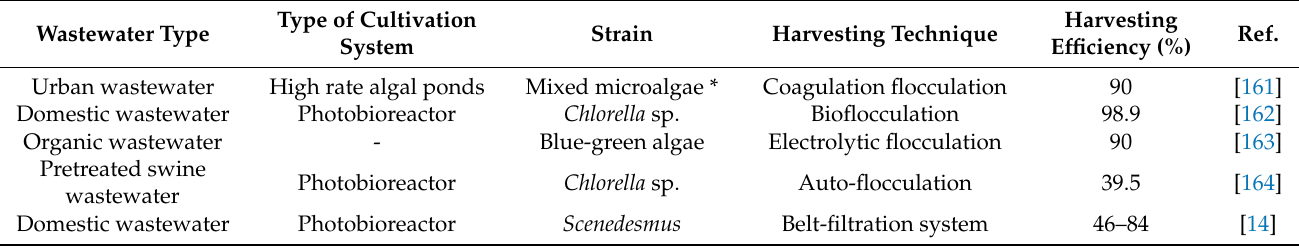
Table 3. Harvesting efficiencies of microalgae grown in different